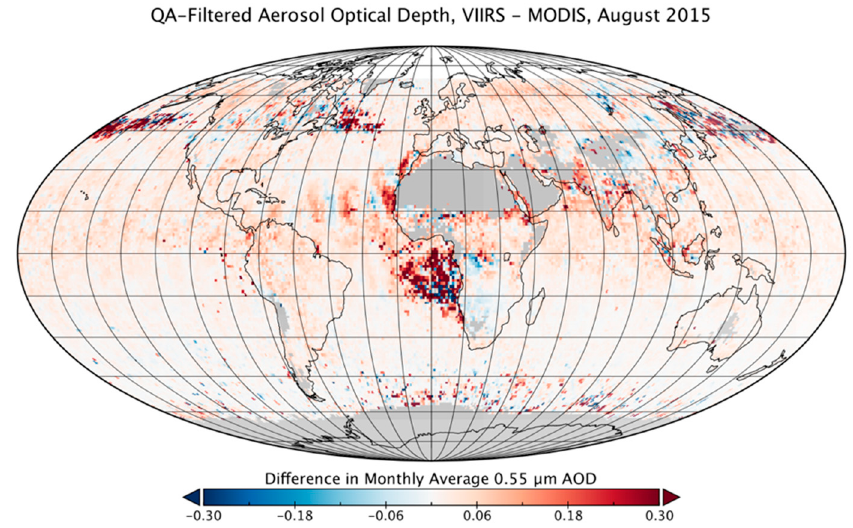
Figure 7. Difference between monthly average QA-filtered 0.55 μ m AOD for August 2015 from VIIRS and MODIS. The global mean difference is +0.02 over ocean and +0.03 over land.